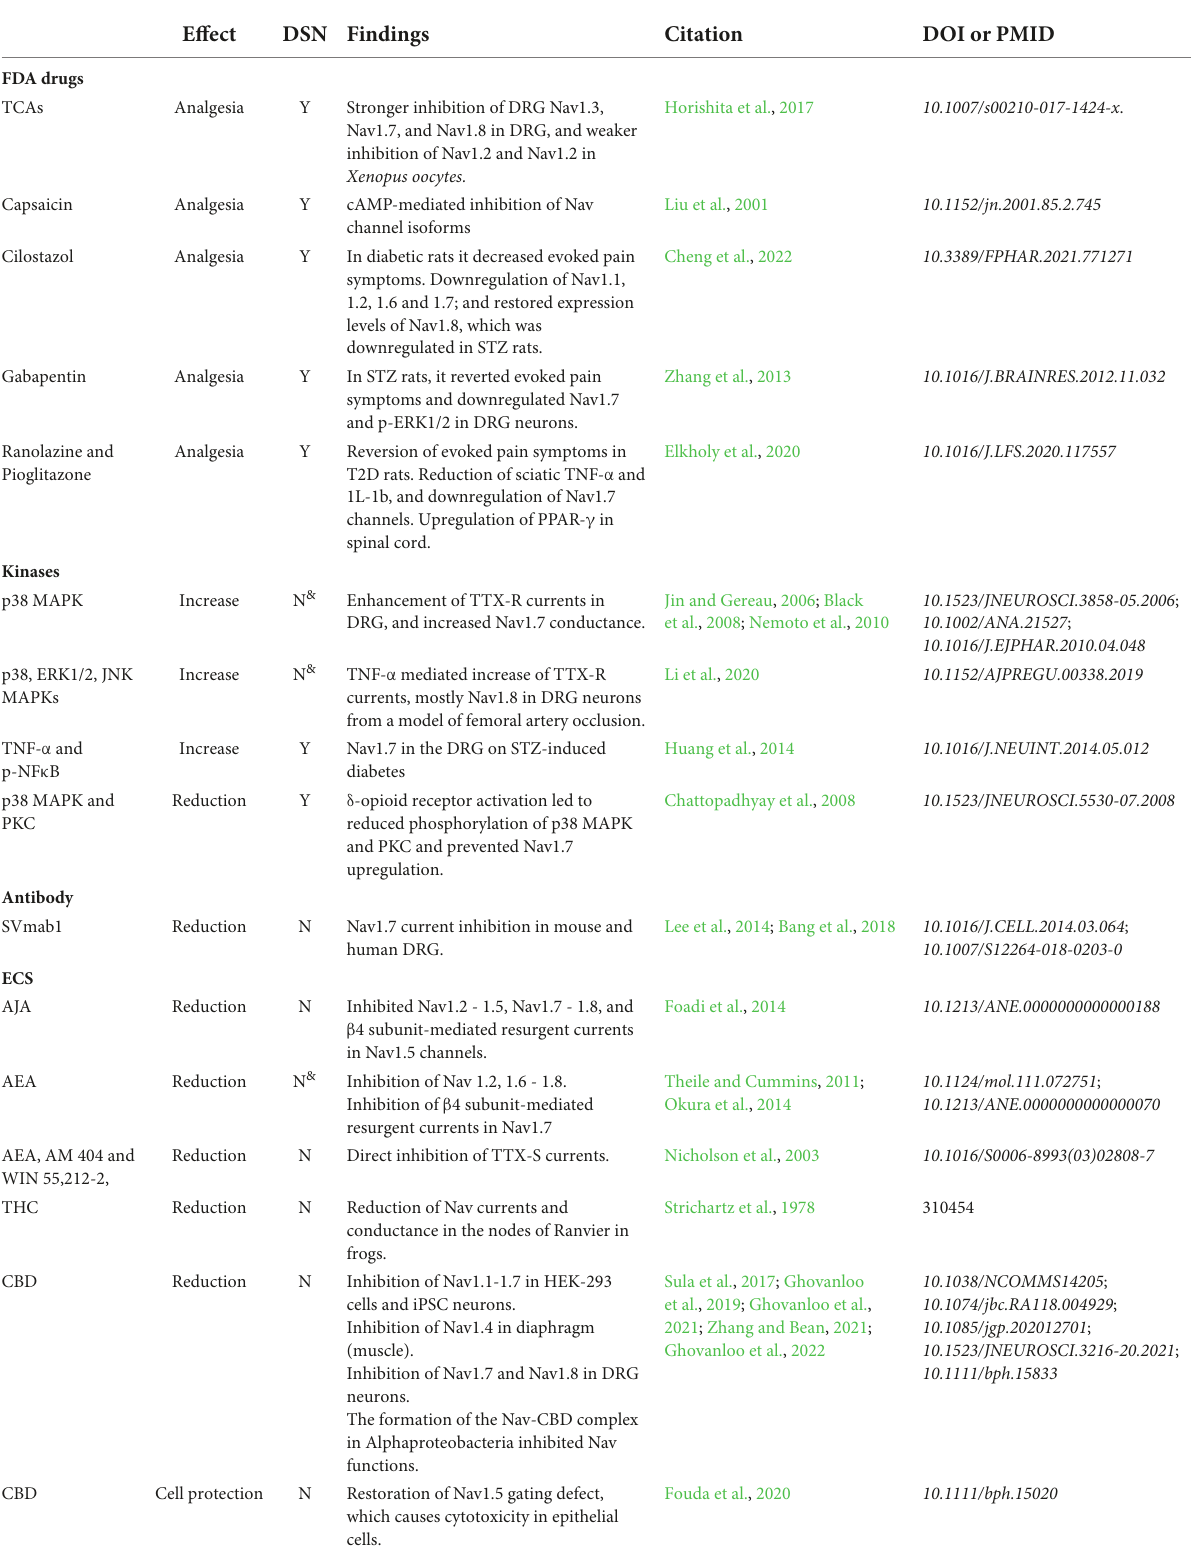
TABLE 1 Modulation of Na V expression and channel function as treatment for